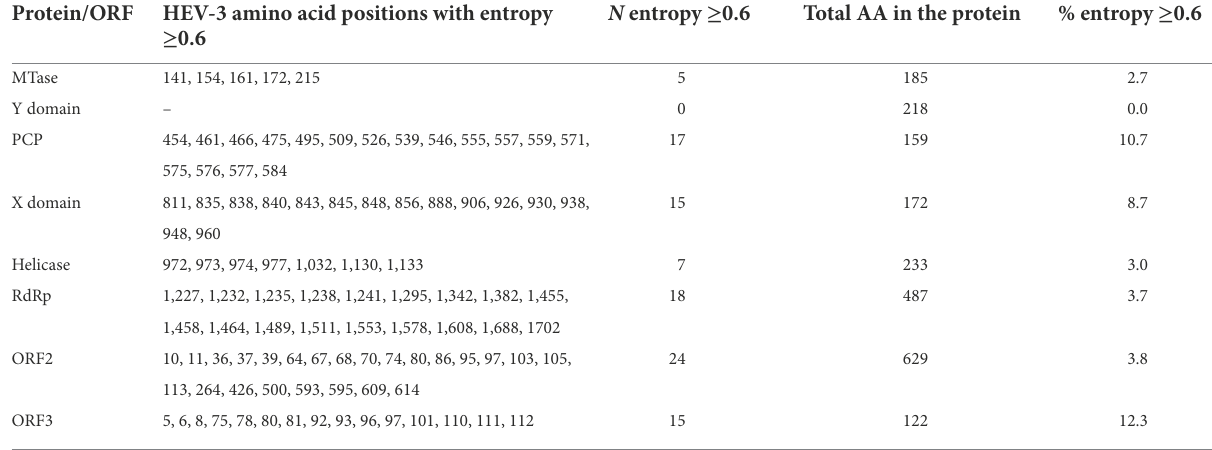
TABLE 1 Amino acid positions with entropy ≥ 0.6 throughout the